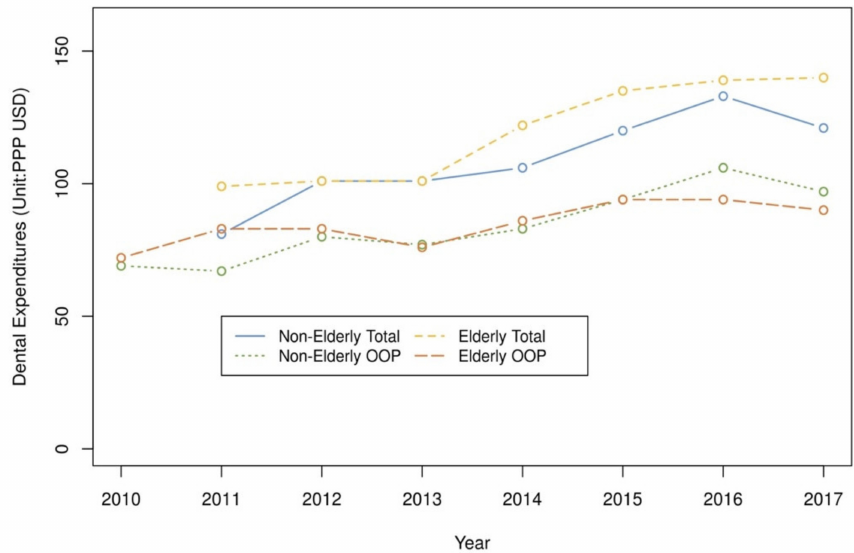
Figure 1. Annual dental expenditures and out-of-pocket spending by age groups. PPP USD: Purchas- ing Power Parity USD [20]; OOP: